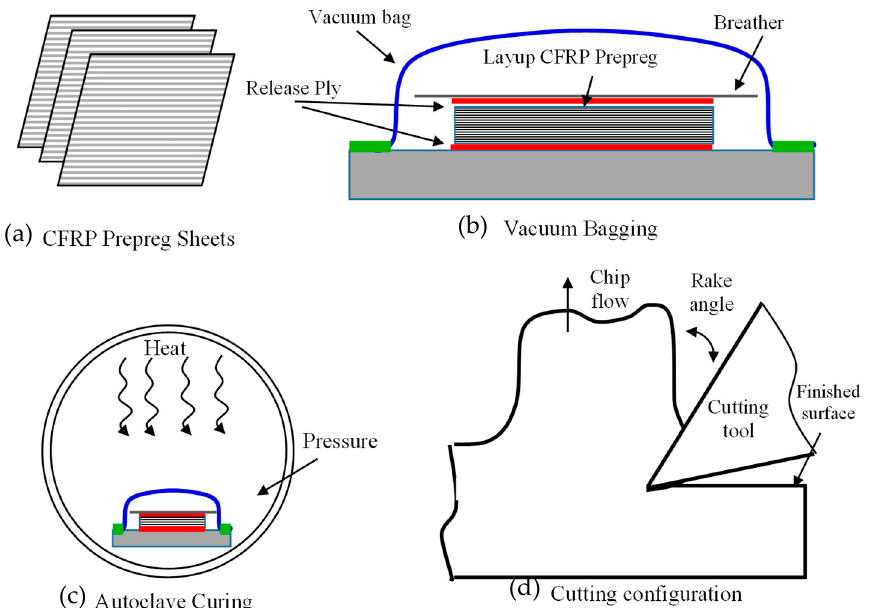
Table 1. To perform the cutting, solid tungsten carbide single-point cutting tools were used, which were brazed onto a steel body with a circular shank. The cutting edges were ground to produce tools with three different rake angles ( − 10°, 10°, and 30°), a constant clearance angle of 10°, and a radius of 20 µm, see Figure 1d.